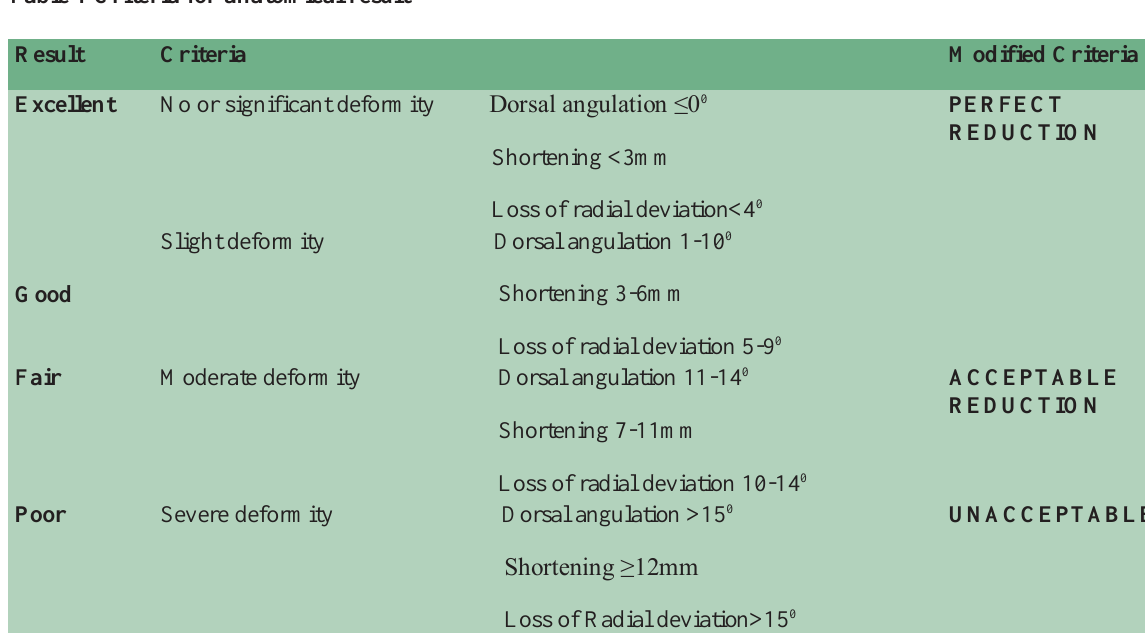
Table 1 Criteria for anatomical result